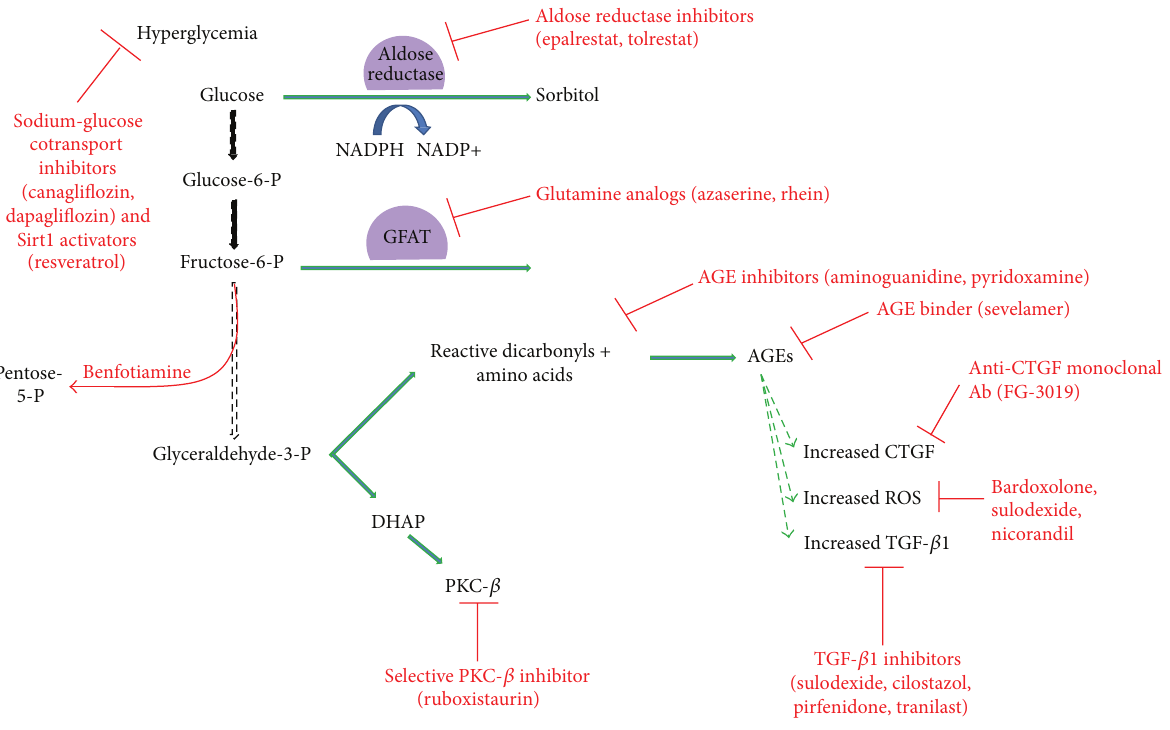
seen in patients with type 1 and type 2 diabetes. Sodium-glucose cotransport (SLGT2) inhibitors and Sirt1 activators play a role in